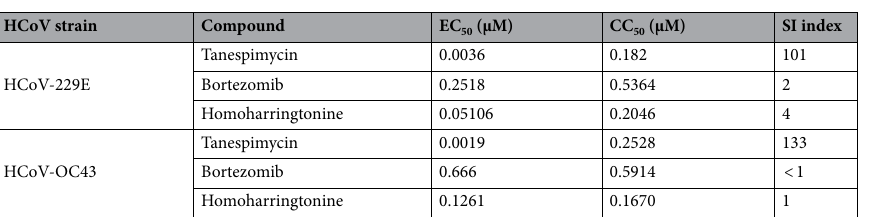
Table 3. (A) EC 50 , CC 50 , and SI index of 3 compounds of interest in MRC5 cells infected with HCoV-229E or HCoV-OC43. Tanespimycin and homoharringtonine exhibited anti-HCoV-229E with tanespimycin’s EC 50 101 times lower than its CC 50 and homoharringtonine 4 times lower. Tanespimycin was also effective against anti- HCoV-OC43 with an